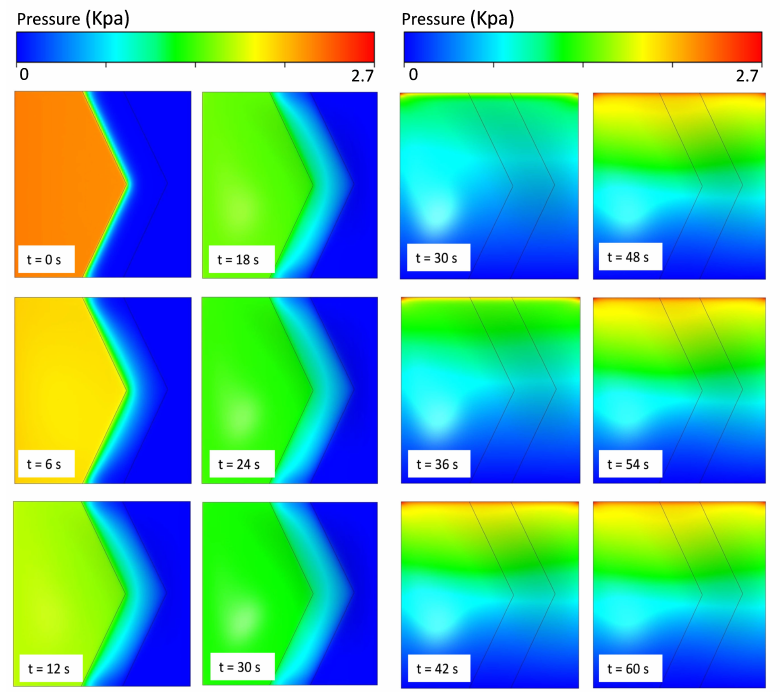
Figure 8. Pressure distribution for various time steps for L/W = 0.65 model in upper surfaces and lower surfaces of membrane in